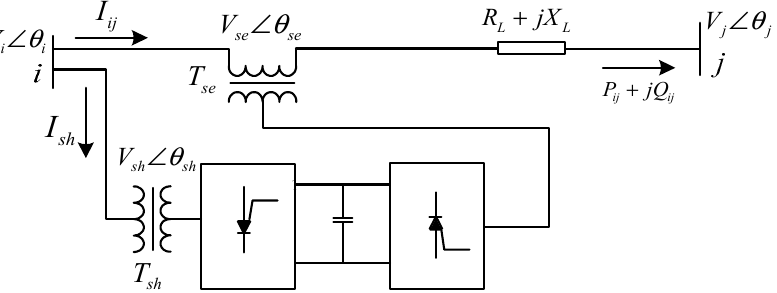
Figure 1. Per-phase schematic diagram of unified power flow controller (UPFC) .